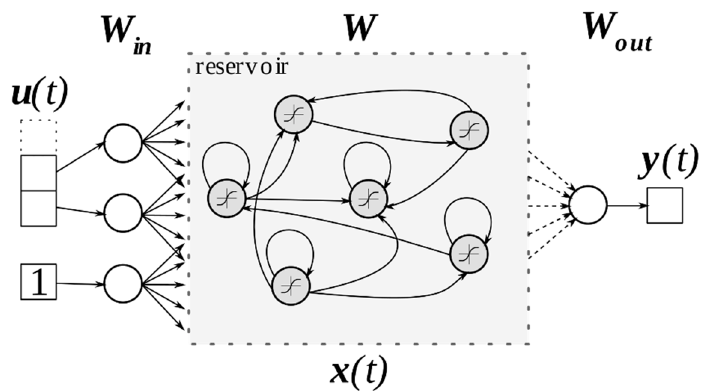
Figure 2. The schematic of echo state network (ESN) architecture. Groups of arrows directed from/to the reservoir indicate connections to all neurons. Solid lines denote fixed weights, whereas dashed lines denote weights computed during training using linear regression. Names of vectors and matrices are situated next to corresponding network components.